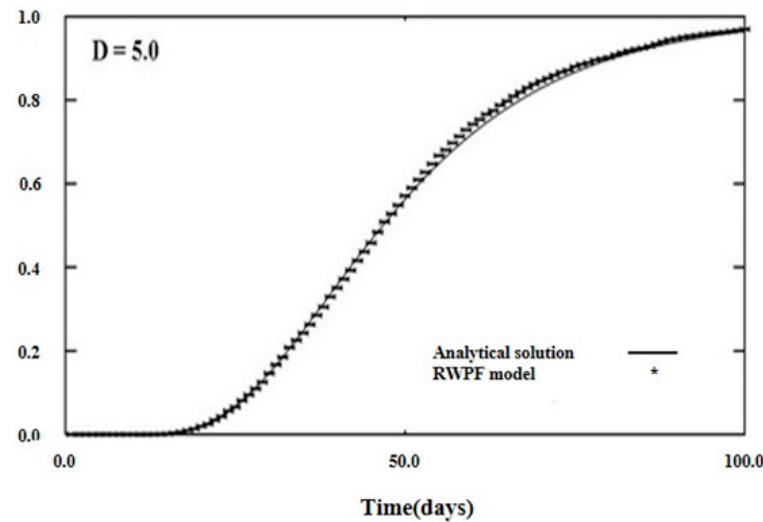
Figure 4. Comparison of simulation results of solute particle transport with D with analytical solutions: the value of R was fixed to 3.0.